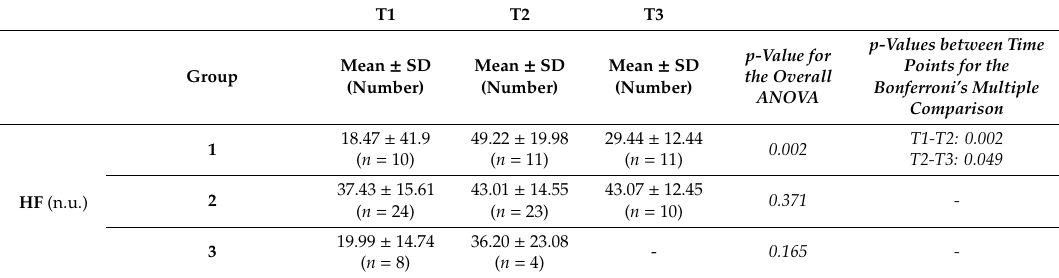
Table 3. HRV parameters in the frequency domain analyses at the three measurement time points (T1, T2, and T3) and in the three treatment